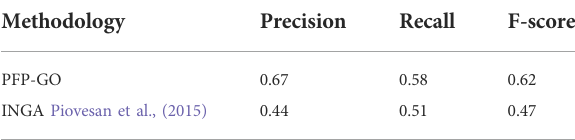
TABLE 2 Performance Analysis of INGA and PFP-GO based on PPI network, sequence, and